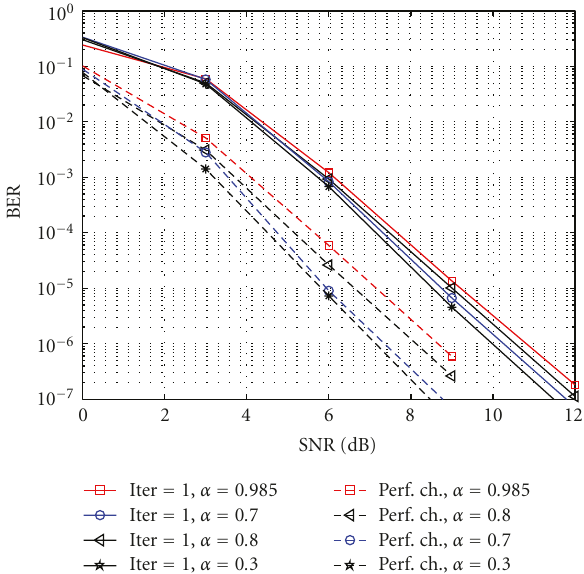
Figure 7: BER performance with varying time correlation with ten